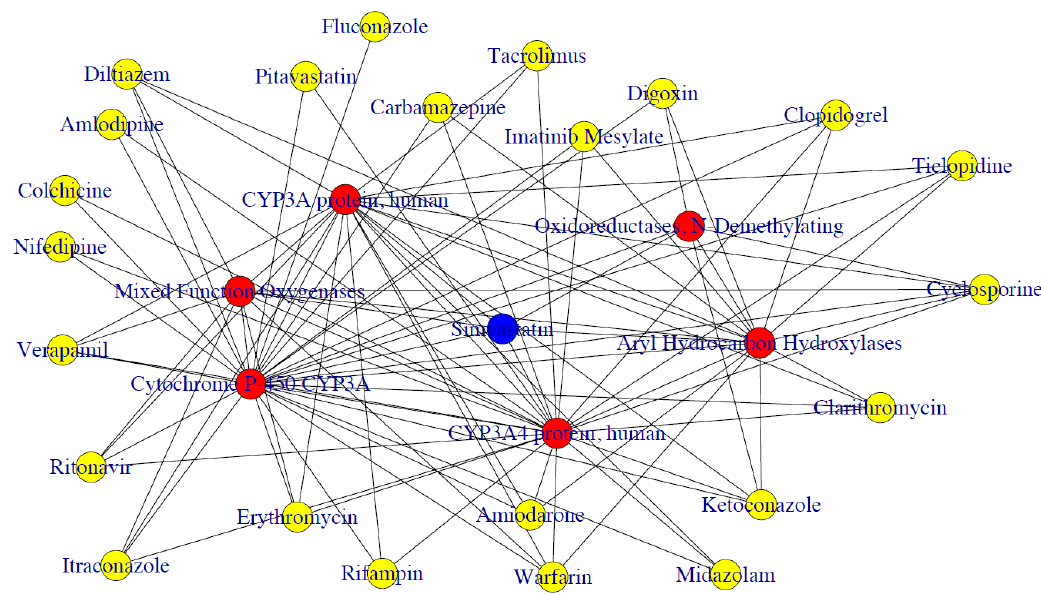
Figure 1. The social network of the proteins and FDA approved drugs identified from CuDDI.